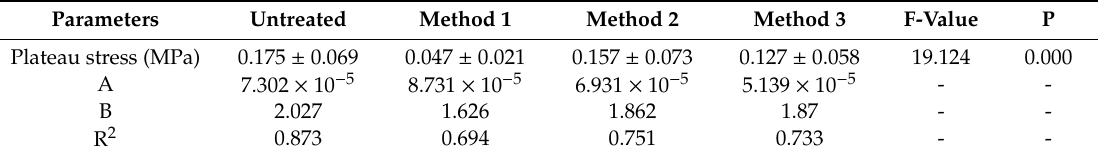
columned lu ff a.